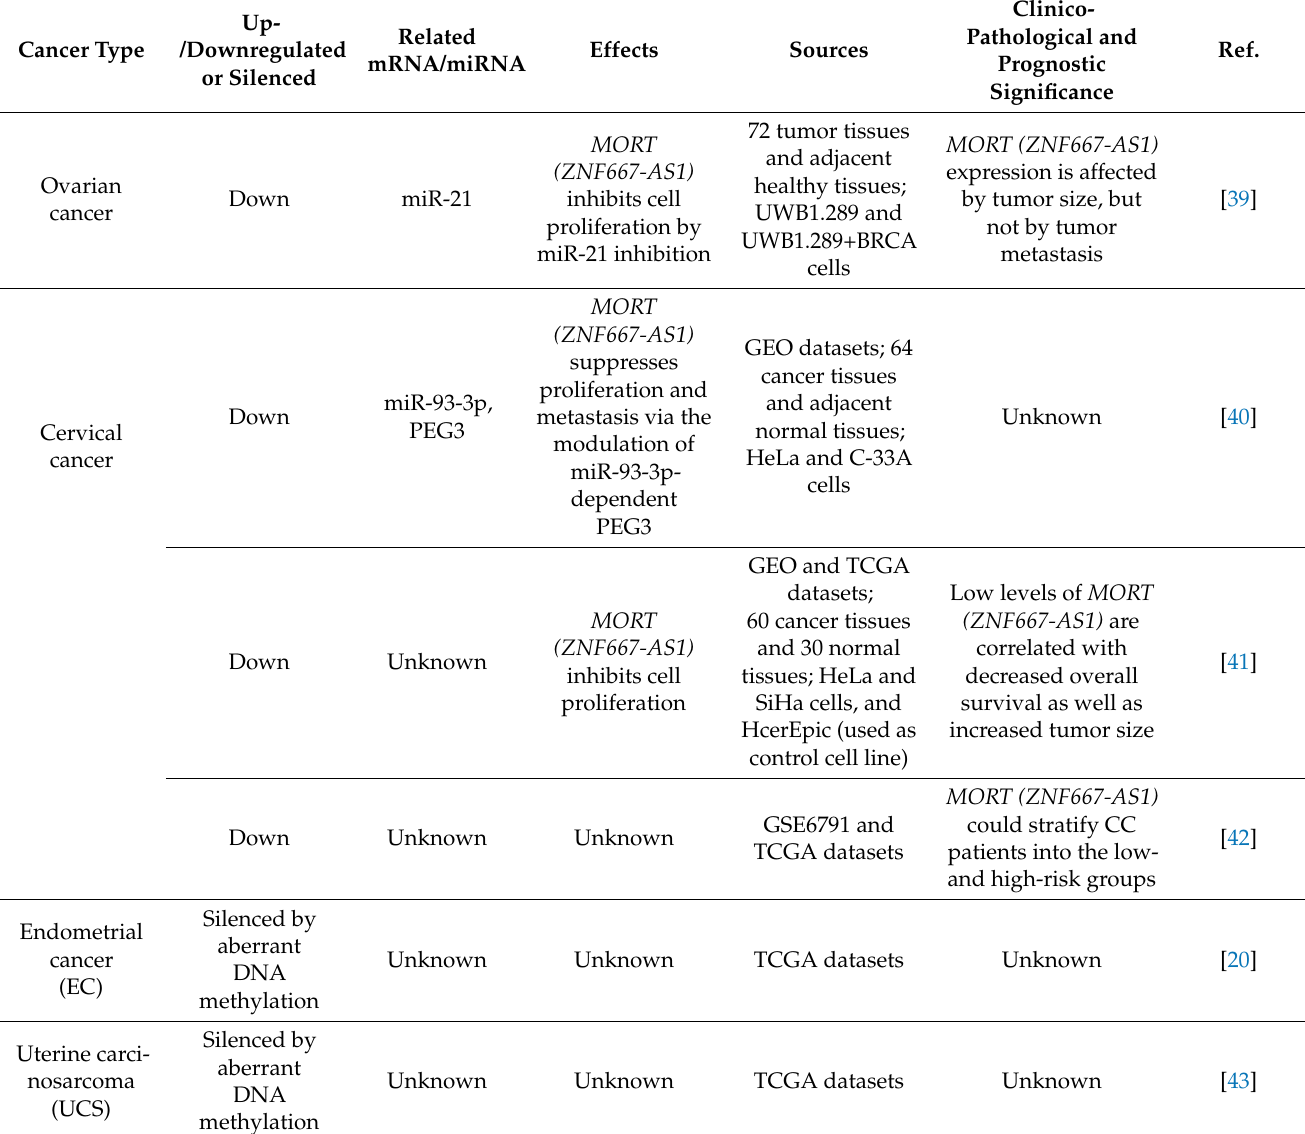
Table 2. Expression of MORT (ZNF667-AS1) and its association with clinicopathological features in gynecological cancers.